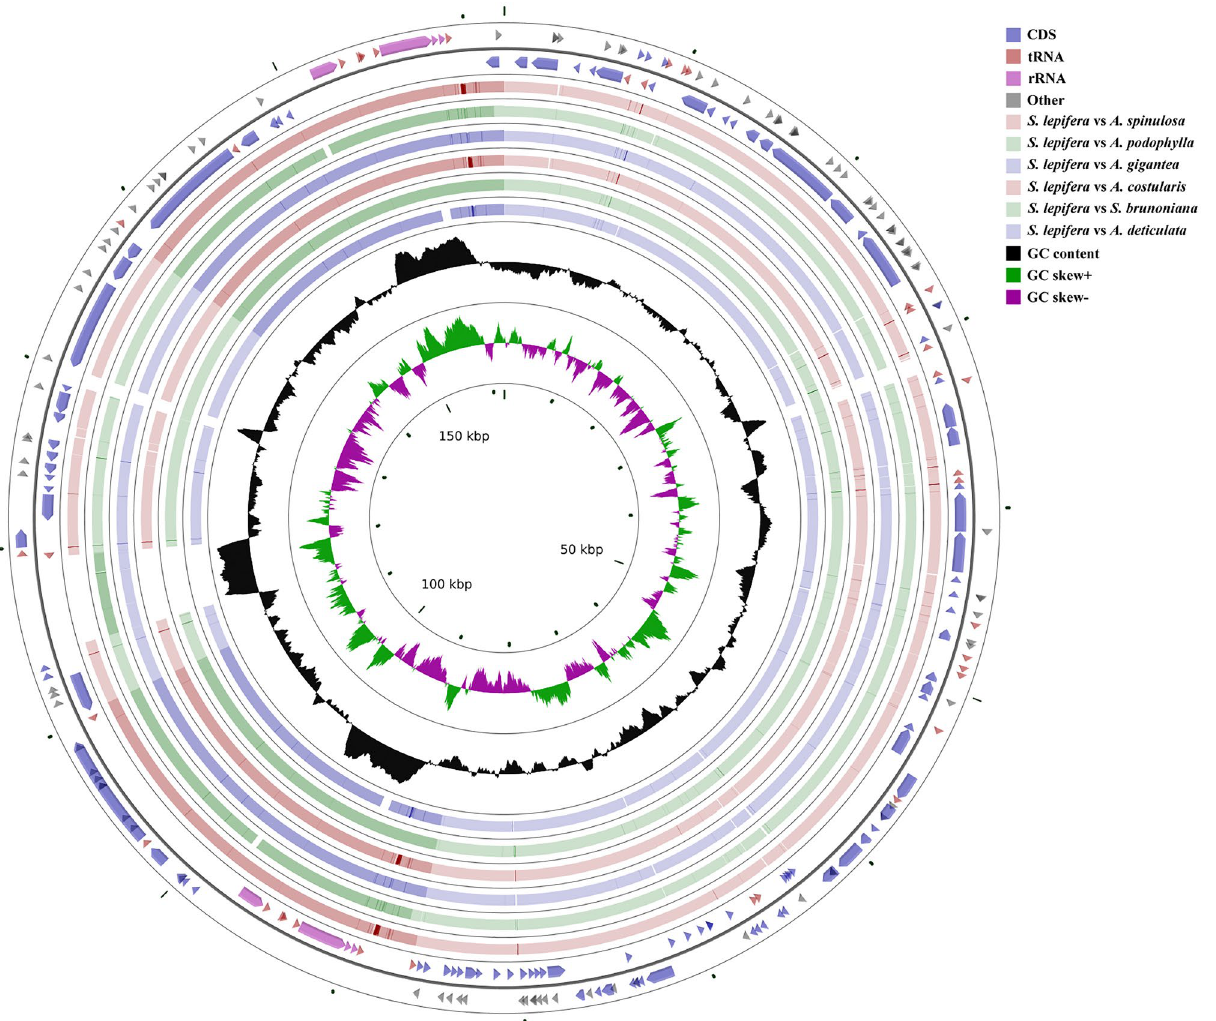
Figure 4. Graphic view of the chloroplast genome structures. The outermost circle shows the gene length, and the second outer circle indicates gene direction. The inner circles represent results of similarity with other reference genome alignments. The black circle represents GC content; green represents GC-skew+; and purple represents